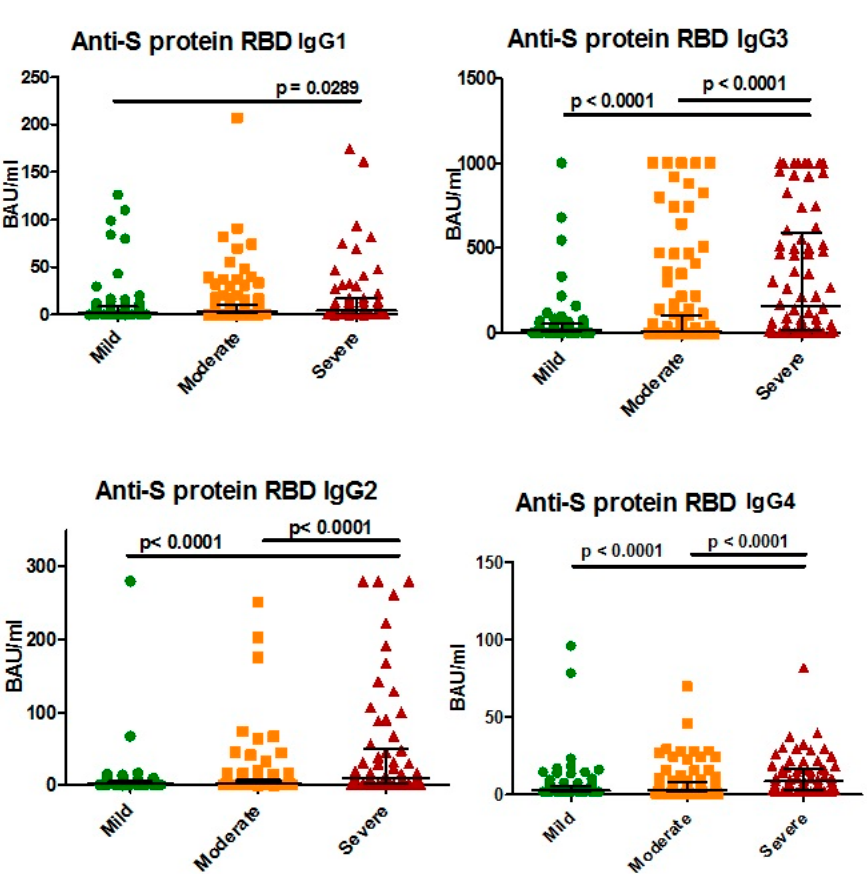
Figure 7. Differences in anti-S protein (RBD) IgG subclass concentration depending on illness severity, Me (Q25–Q75).